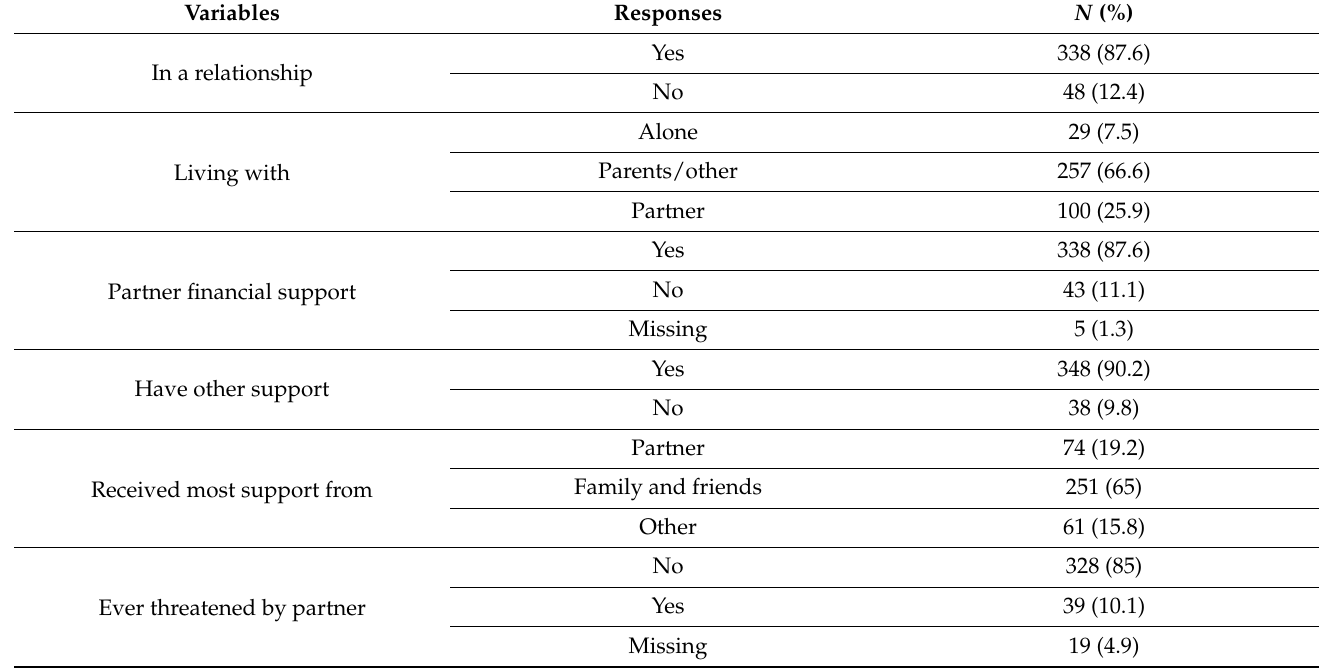
Table 2. Social characteristics of the